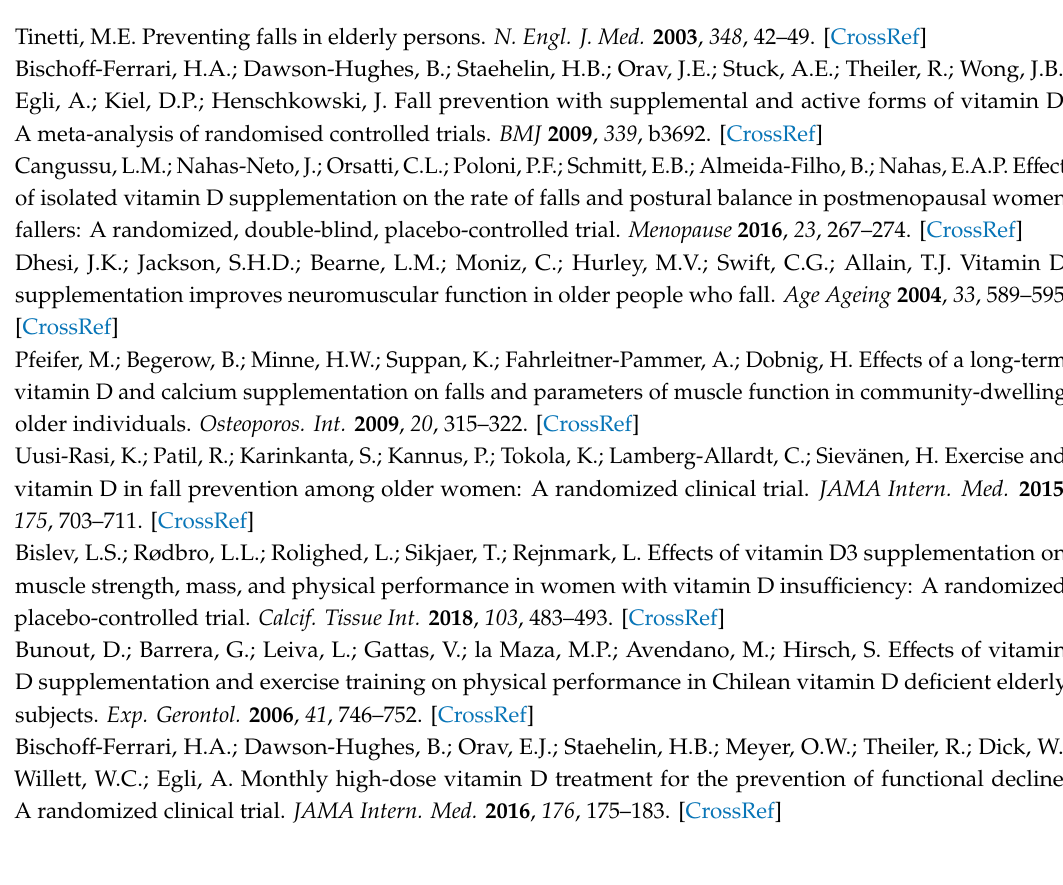
Figure S1: Flow diagram of participants in the study, Table S1: Baseline and absolute mean change (SD) from baseline by treatment groups for medio-lateral (ML) sway index, Table S2: Baseline and absolute mean change (SD) from baseline by treatment groups for anterior-posterior (AP) sway index, Table S3: Adjusted mean absolute di ff erence (95% confidence interval) in medio-lateral (ML) sway index between treatment groups using linear mixed e ff ects modeling, Table S4: Adjusted mean absolute di ff erence (95% confidence interval) in anterior-posterior (AP) sway index between treatment groups using linear mixed e ff ects